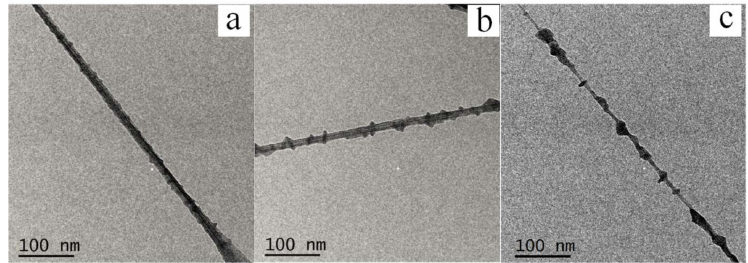
Figure 1. TEM images of PE21M/SWCNT nanocomposites produced in p -xylene at different temperatures for 6 h. ( a ) 40 ◦ C, ( b ) 50 ◦ C, ( c ) 60 ◦ C (both PE21Br and SWCNT concentrations are 0.05 wt